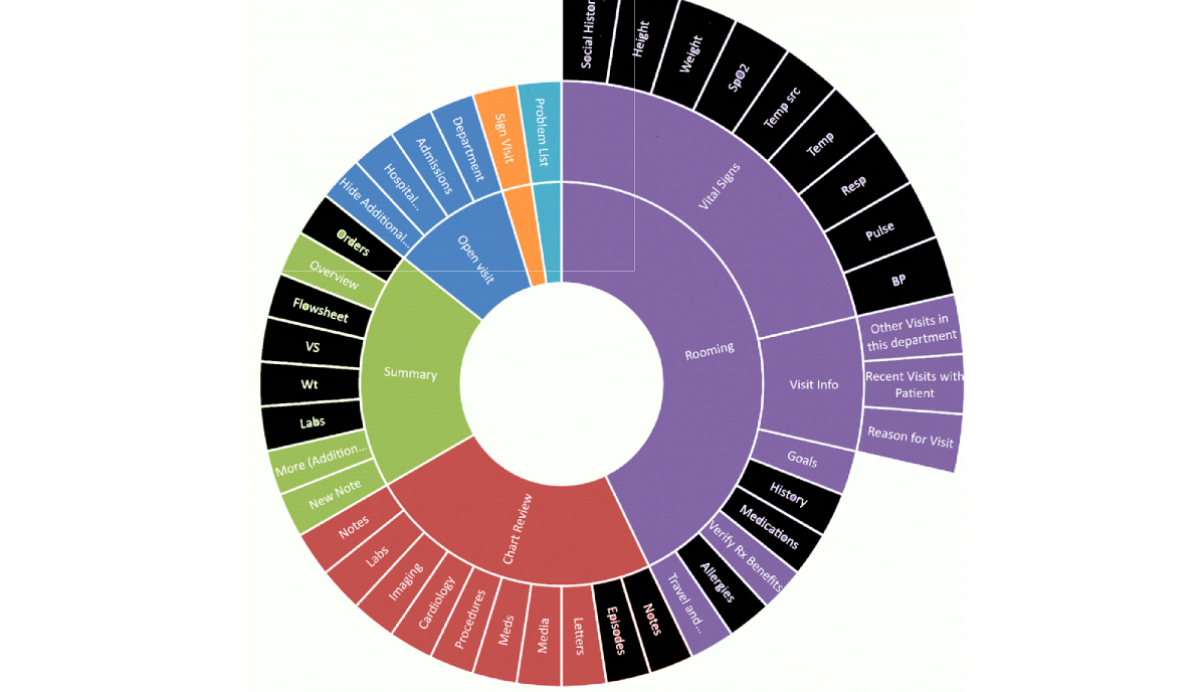
Illustration Results: Using Time Belts to Compare Task Fragmentation and Workflow for a Conventional EHR and a Composable